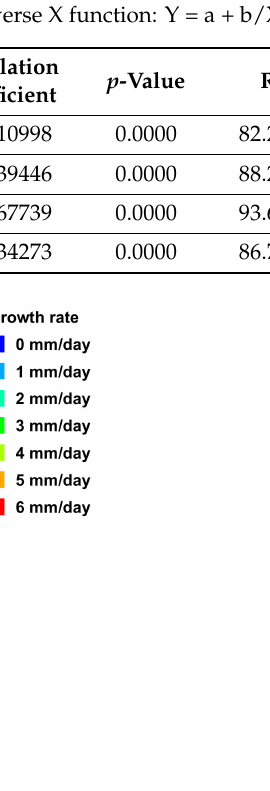
Table 2. Equations and correlation coefficients between growth rate (mm · d − 1 ) and water activity